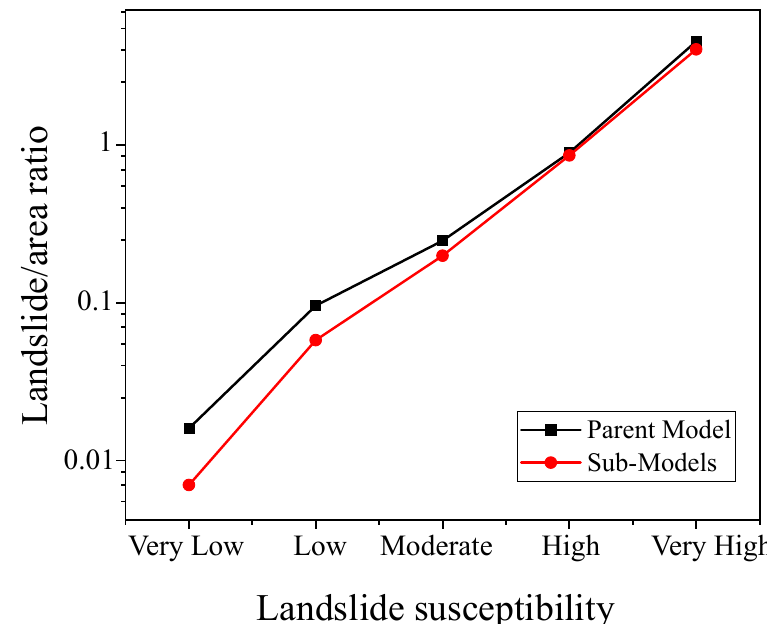
Figure 9. Landslides/area ratio.